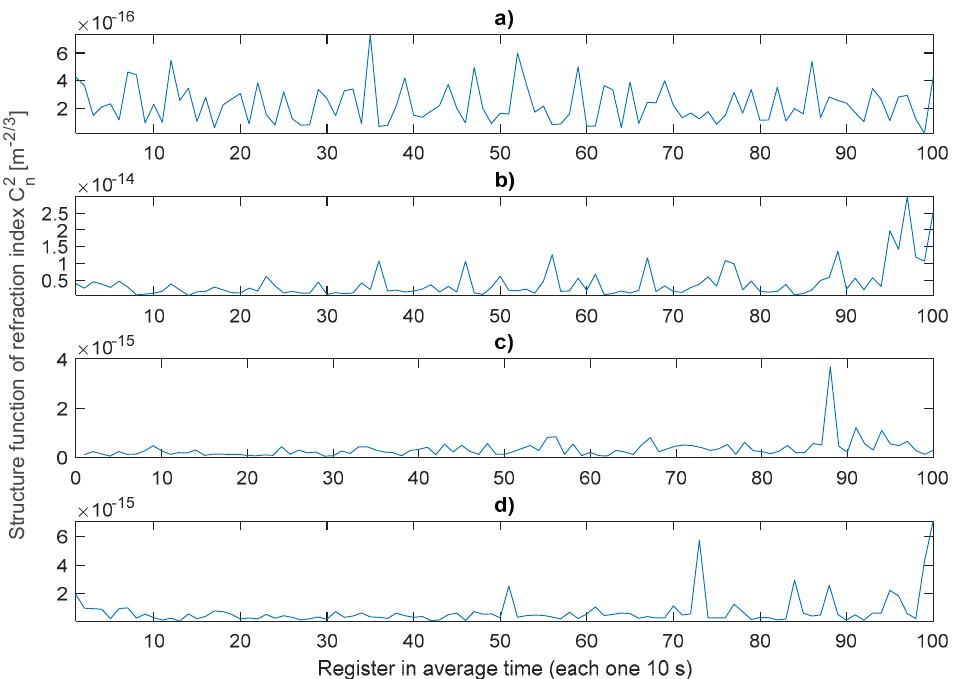
Figure 16. Refraction index structure constant C 2 n according to Test: ( a ) Pattern. ( b ) Test #1. ( c ) Test #2. ( d ) Test #3. Source: Authors.